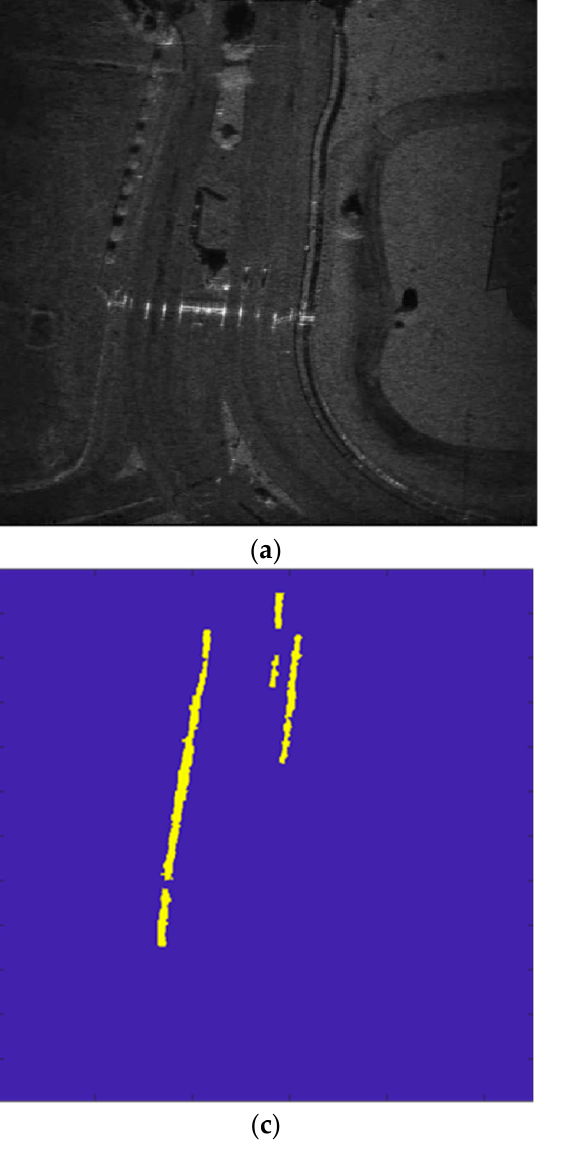
Figure 6. Frame 19 detection results: ( a ) video SAR image; ( b ) foreground image; ( c ) motion track; ( d ) final detection result.